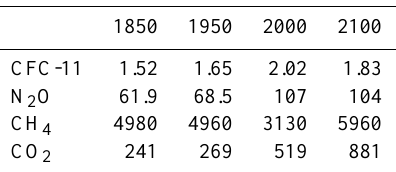
Table 1. Steady state 2-D model calculated annual/global average flux (kgs − 1 ) required to produce a 1% change in annually averaged global total ozone for the compounds and years listed. The ozone change is negative for CFC-11 and N 2 O, and positive for CH 4 and CO 2